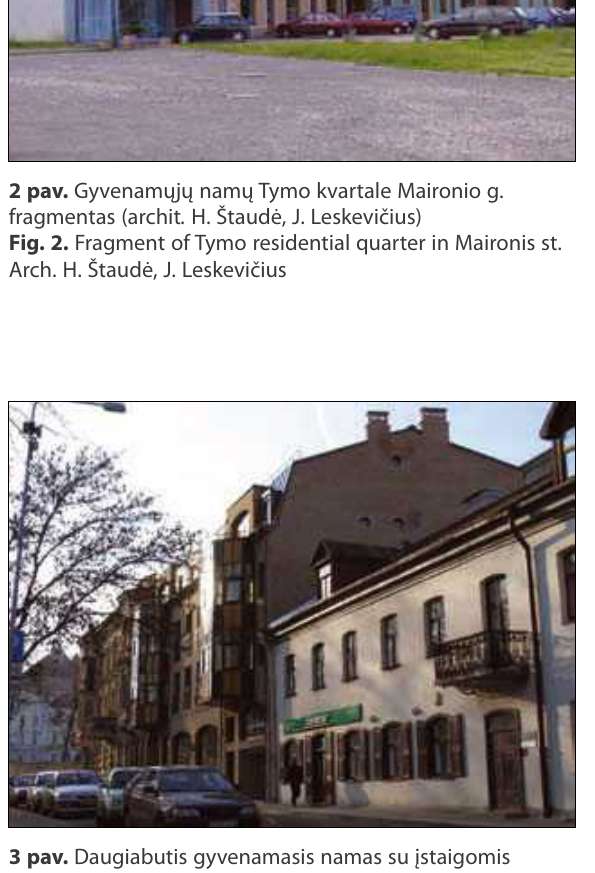
Fig. 3. block of flats with offices in L. Stu­oka-Gu­cevičiu­s st.